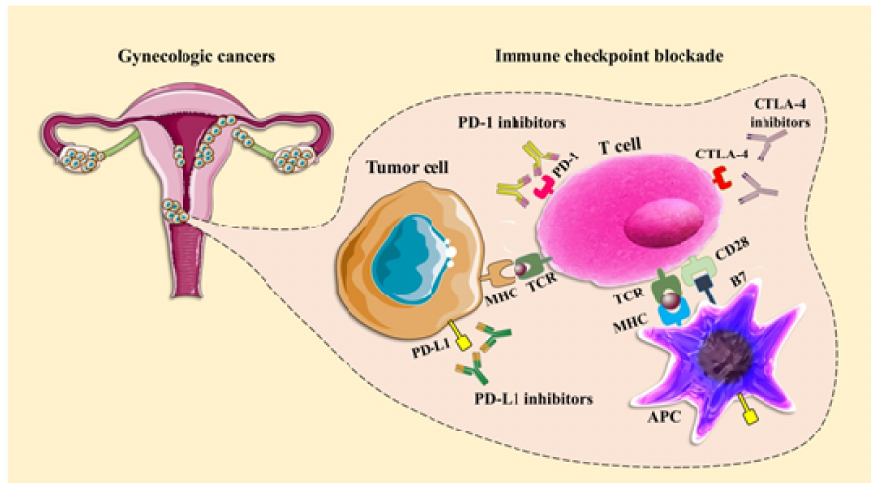
Figure 1. The mechanism of action of programmed cell death protein-1 (PD-1), programmed death ligand-1 (PD-L1), and cytotoxic T-lymphocyte-associated protein 4 (CTLA-4) inhibitors in cancer immunotherapy. Gynecologic cancers comprise a group of cancers that begin in the female reproductive system. The activation of T cells is mediated by the interaction of the T cell receptor (TCR) and the CD28 receptor with major histocompatibility complex (MHC) and the B7 co-stimulatory molecule located on the antigen-presenting cells (APCs). The interaction of CTLA-4 with the B7 molecule initiates an inhibitory signal, which is e ff ectively blocked by CTLA-4 inhibitors. On the other hand, the negative regulation of T cells resulting from PD-1 / PD-L1 interaction between T cells and tumor cells is suppressed by PD-1 / PD-L1 inhibitors. CTLA-4 and PD-1 / PD-L1 blocking antibodies have been shown to exert clinical antitumor activity in patients with gynecologic cancers. The figure is modified from Servier Medical Art (https: //